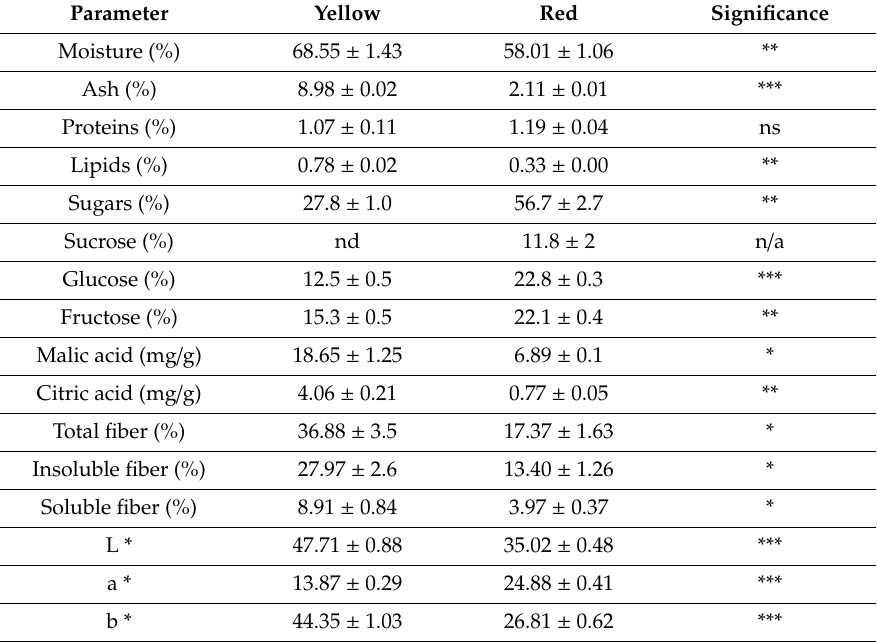
Table 2. Physico-chemical characteristics (mean values ± standard error) of the two fresh Tunisian P. canariensis dates and results of variance